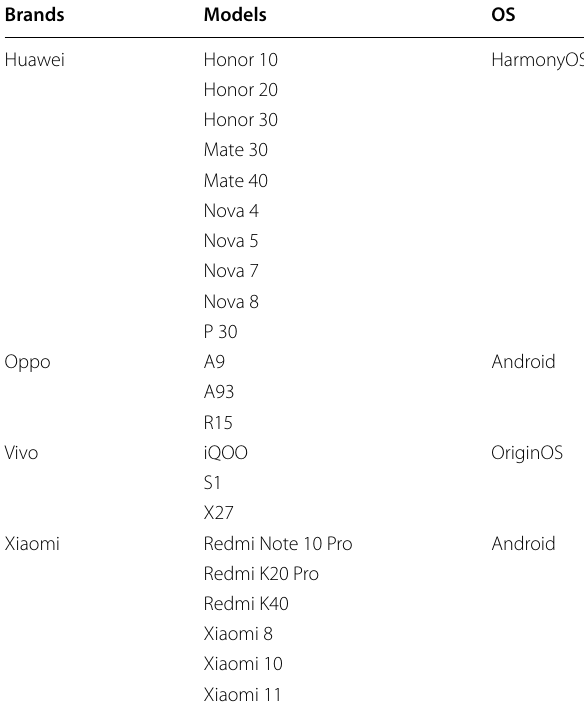
Table 1 The details of the